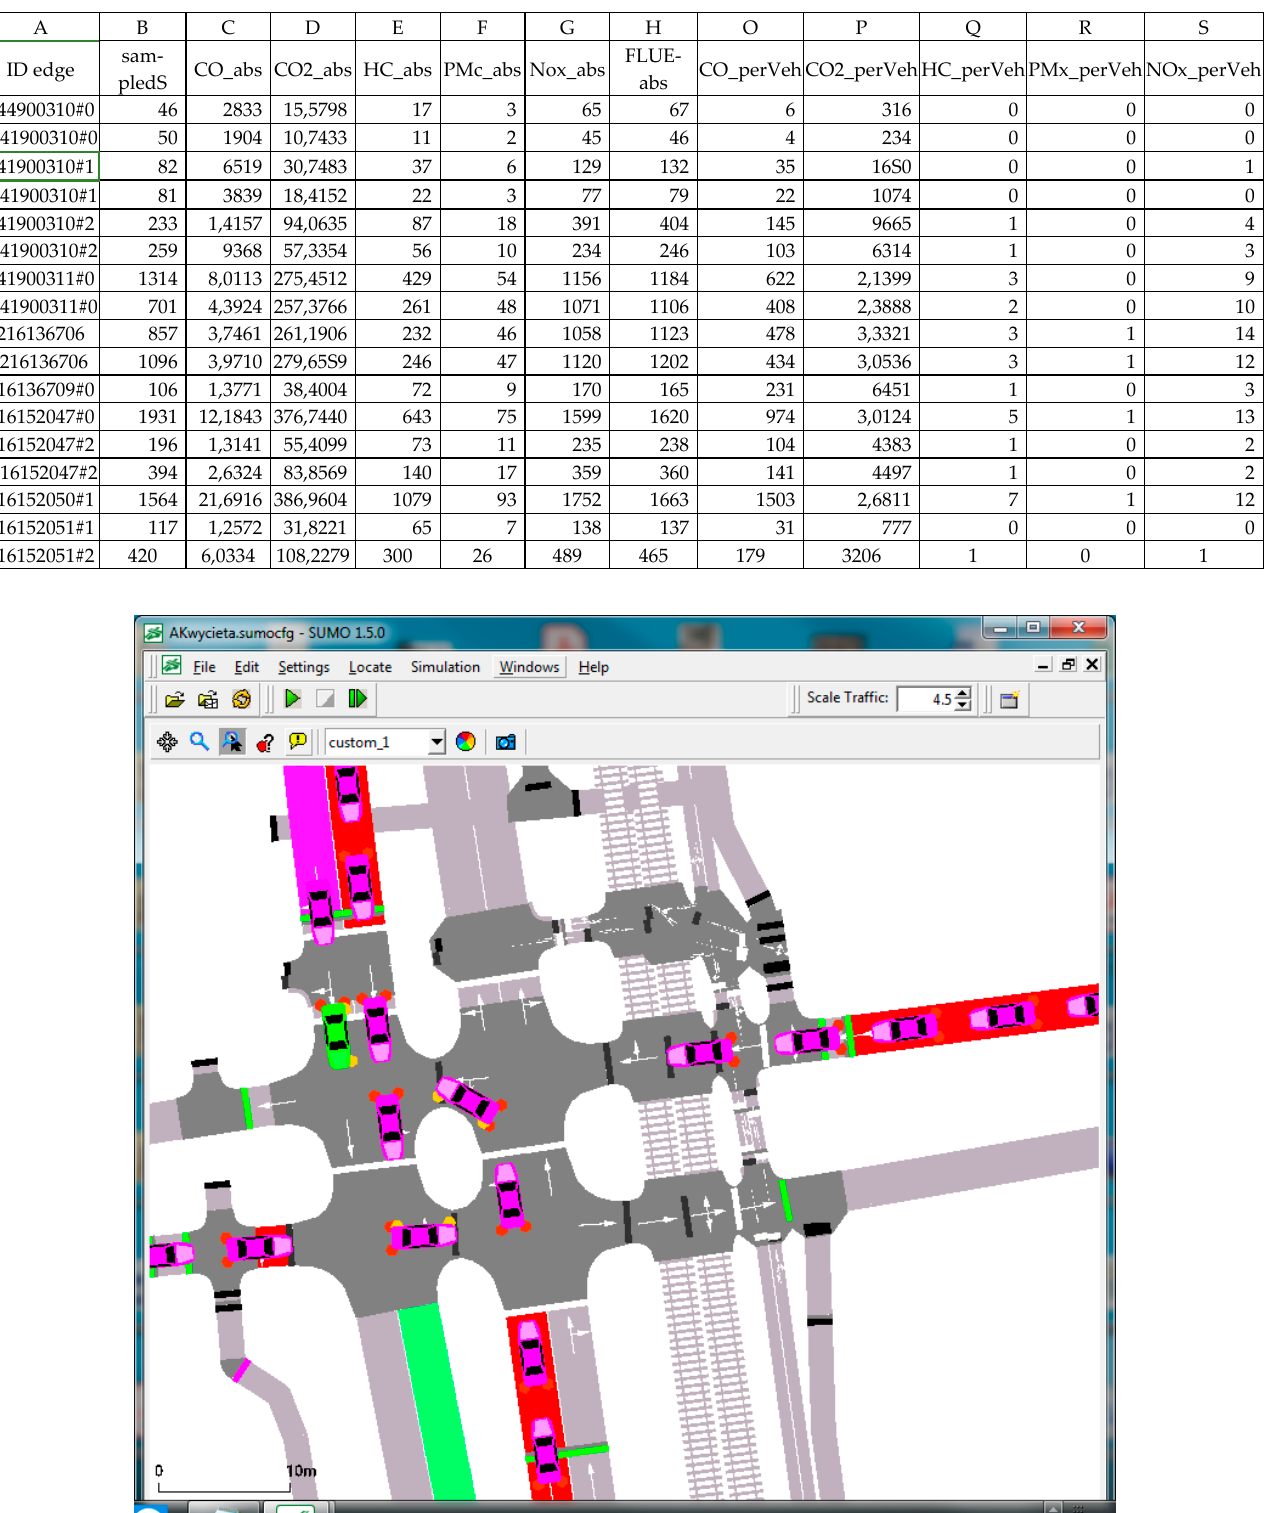
Table 4. Report on analysis of emission on lanes of the artery.